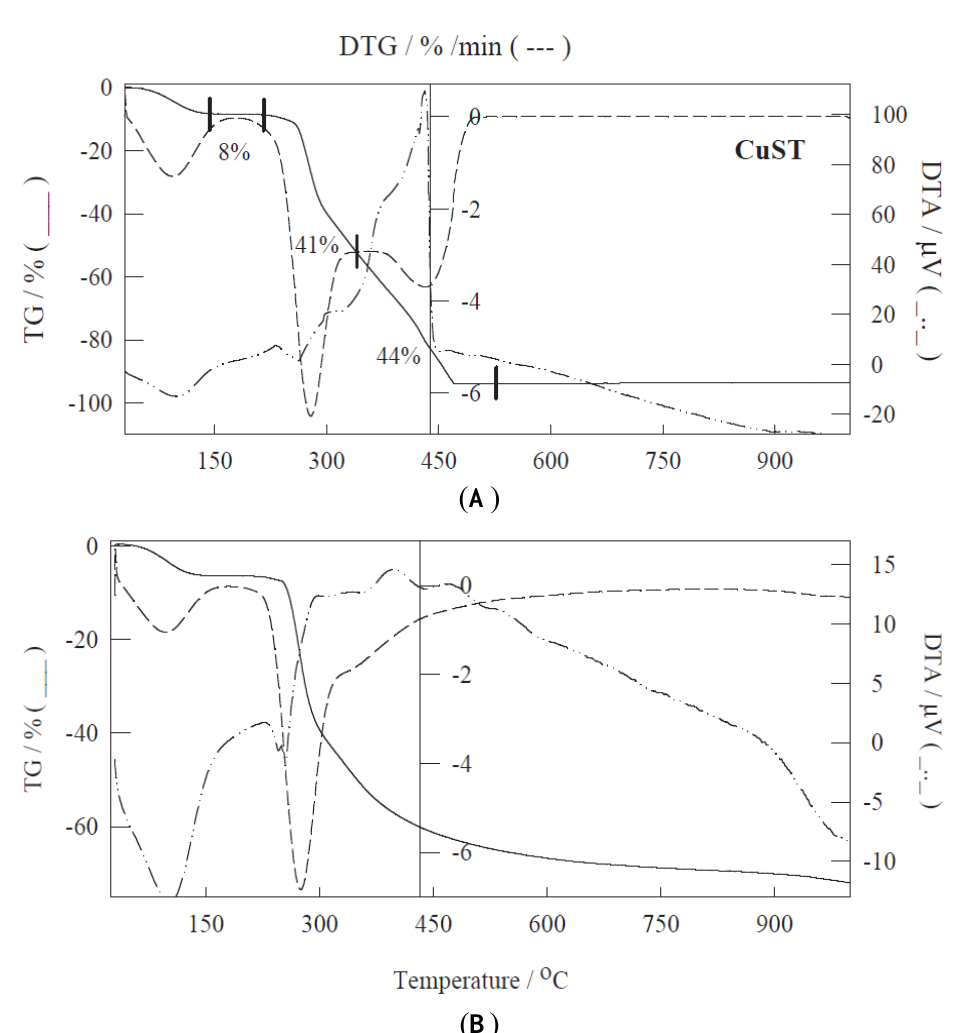
Figure 3. TG, DTG and DTA curves of Cu-ST under oxidizing (Air, A ) and inert atmosphere (Ar, B